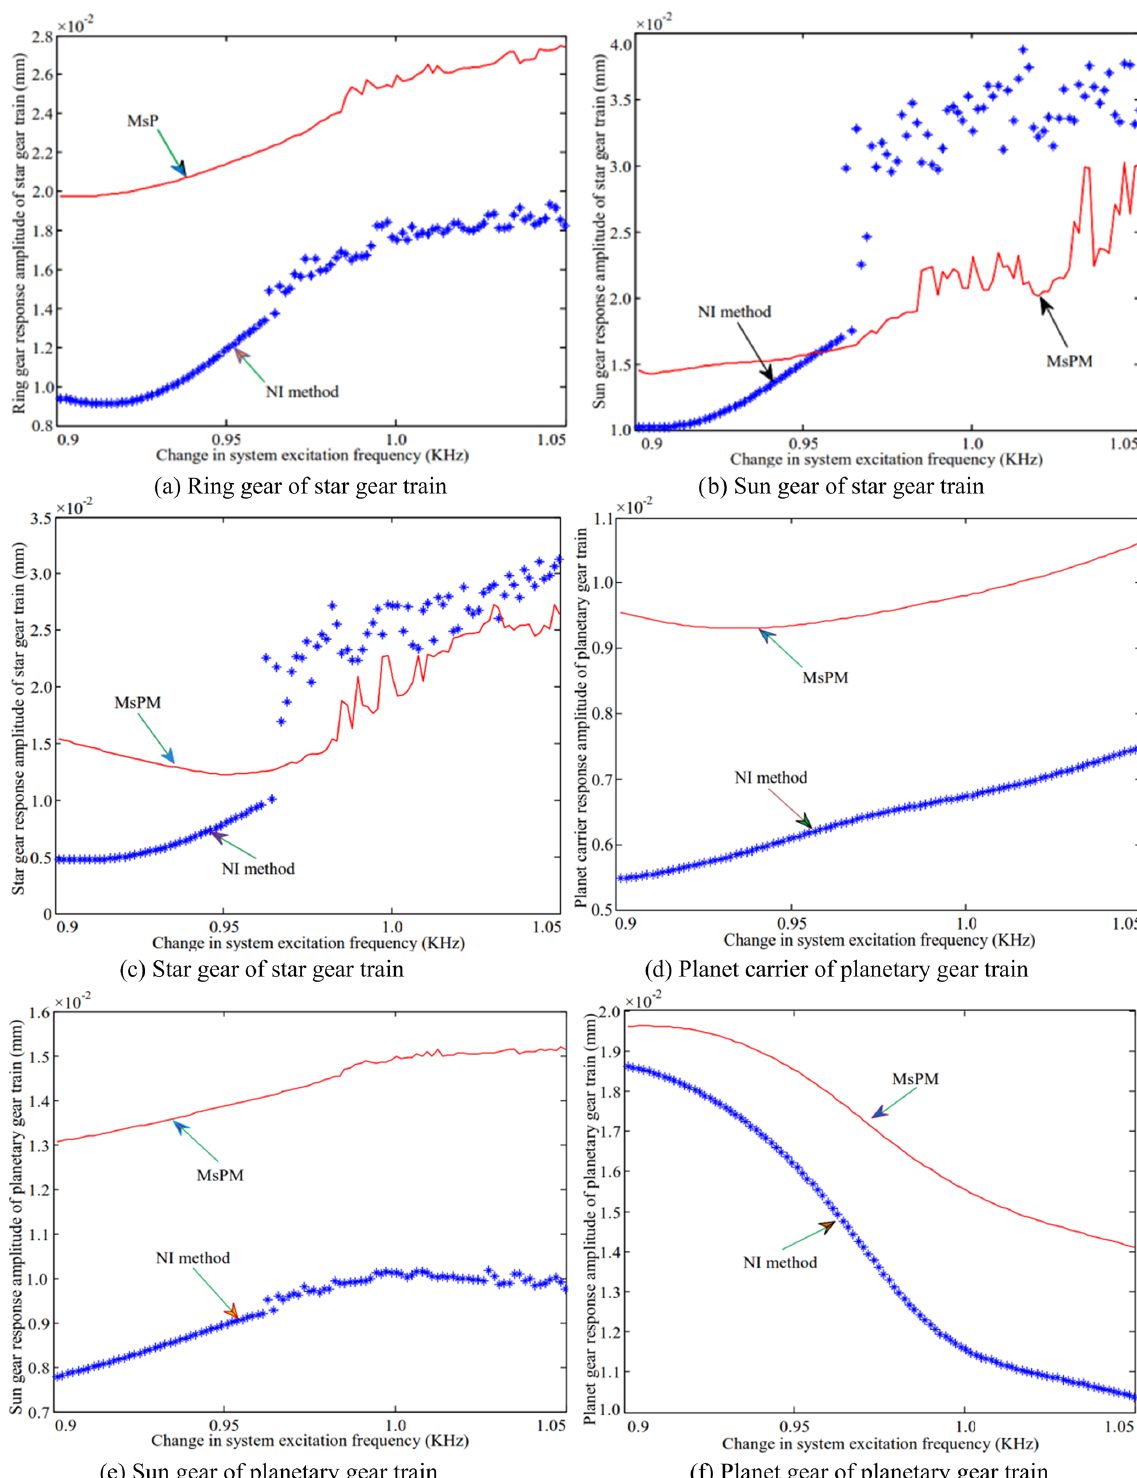
Figure 5. Amplitude–frequency variation curve of each component of the planetary gear